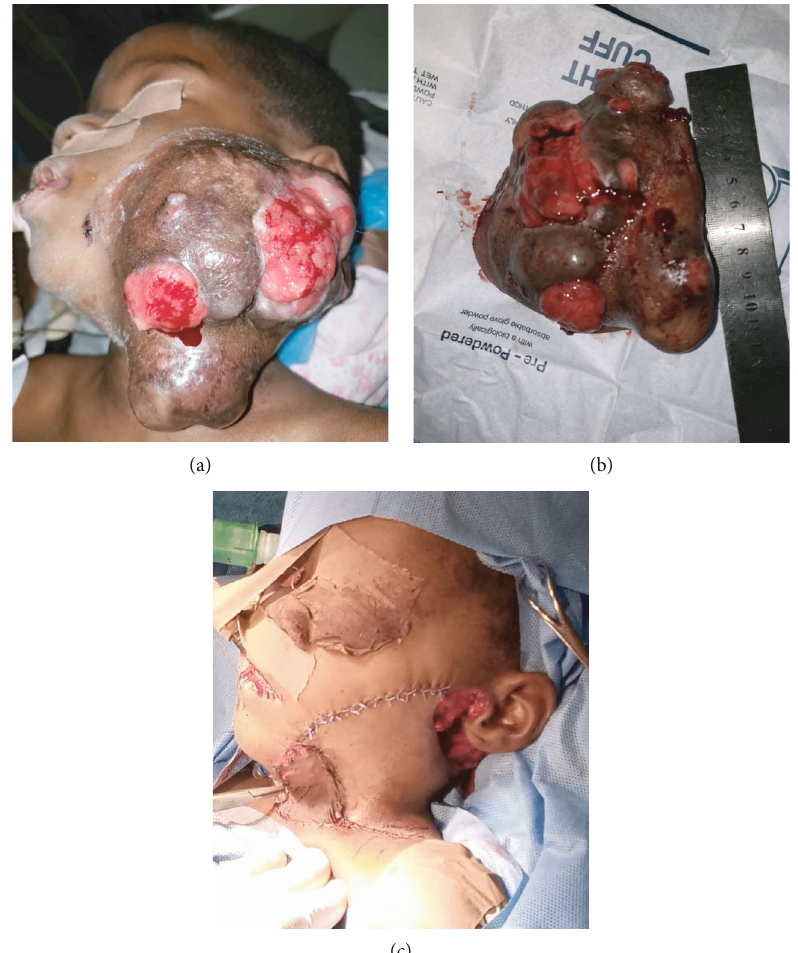
Figure 4: Presurgical clinical image of a female child diagnosed with a MAML2 -rearranged mucoepidermoid carcinoma of the parotid gland (a). Massive 12cm resected MAML2 -rearranged mucoepidermoid carcinoma of the parotid gland (b). Reconstruction of the surgical defect with a skin fl ap (c).